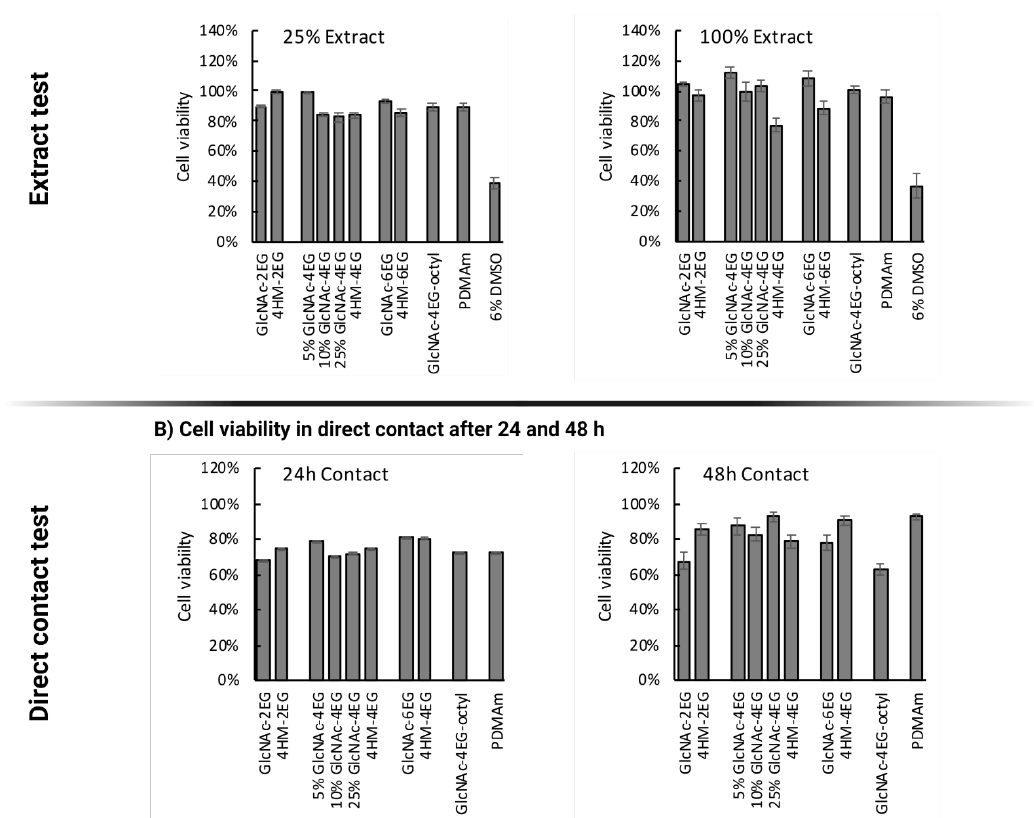
Figure 7. Cytotoxicity determination according to ISO 10993-5. ( A ) Cell viability measured with MTT assay after 72 h of incubation with 100% and 25% extracts; 6% DMSO was used as positive control for cytotoxicity. In both cases, no cytotoxicity was observed for the antimicrobial 5%-GlcNAc-4EG polymer. ( B ) Cell viability in direct contact test after 24 and 48 h, determined by MTT assay. The main functional polymer, 5%-GlcNAc-4EG, showed no more than a 20% decrease in cell viability by the direct contact test.